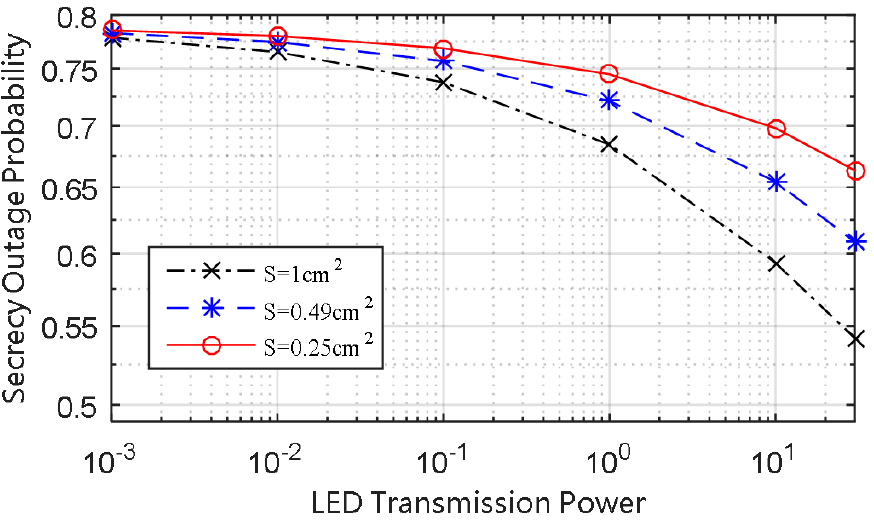
Figure 5. SOP of the strong user versus the physical detecting area of the